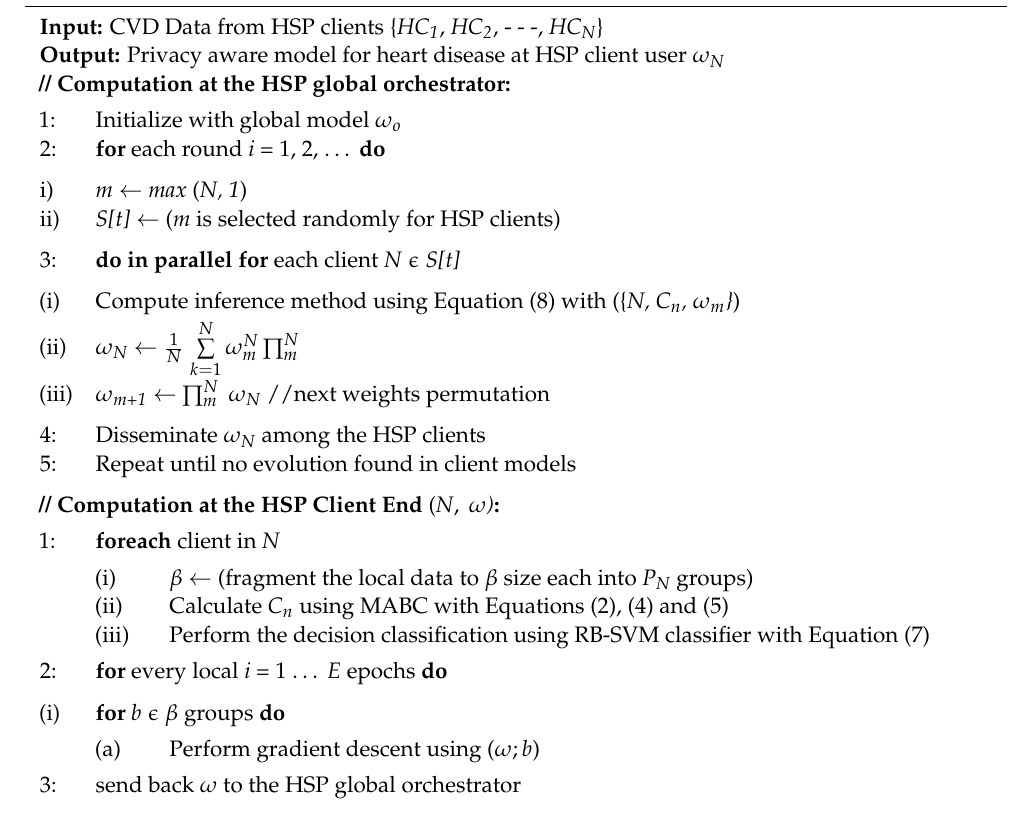
Algorithm 1: Proposed hybrid FL-based framework for heart disease